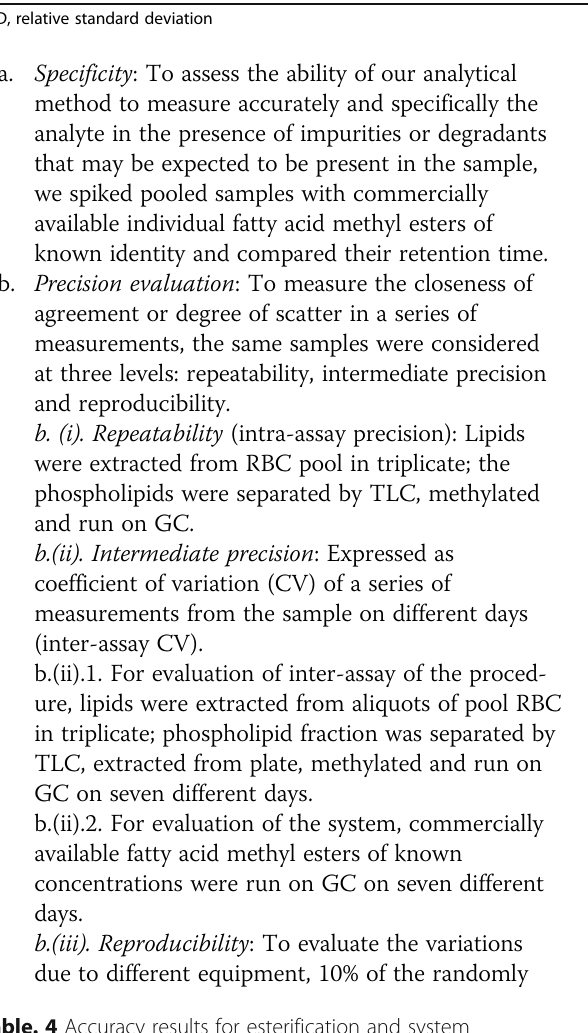
Table. 4 Accuracy results for esterification and system Fatty